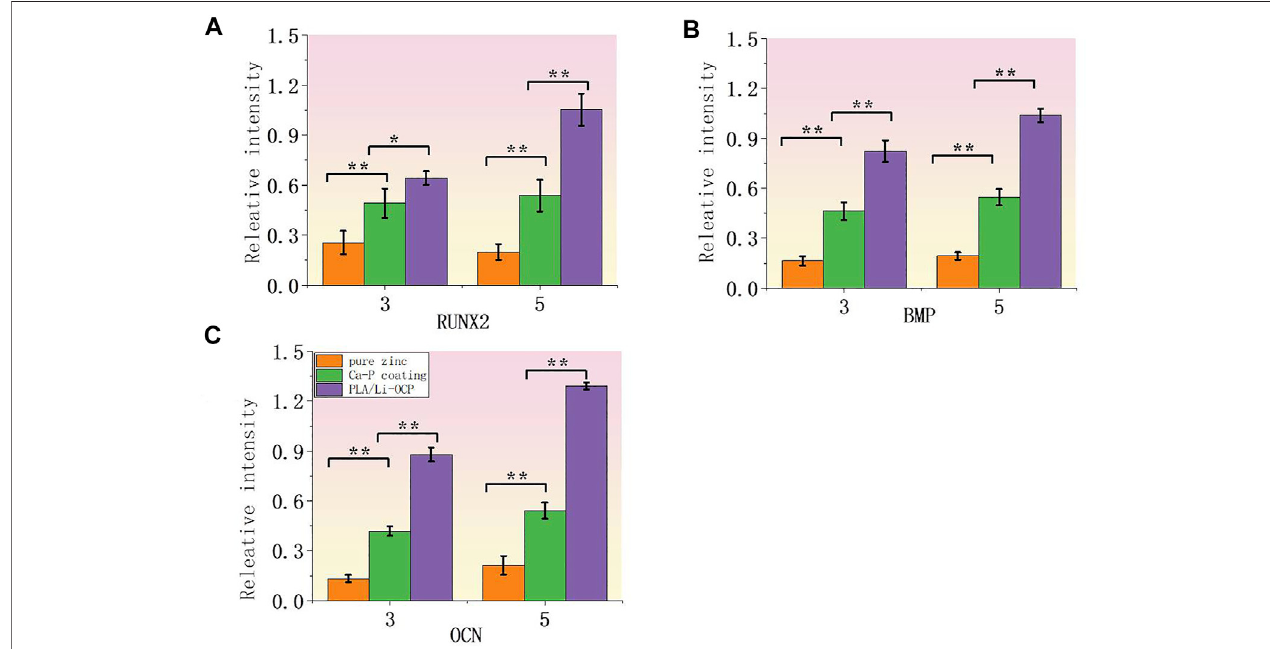
FIGURE 9 | Expression of related osteogenic genes: (A) RUNX2, (B) BMP, and (C) OCN (* p > 0.05, ** p < 0.05).